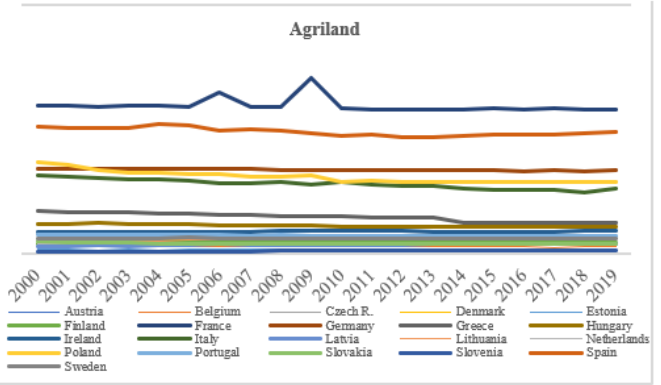
Figure 1. Indicators’ evolution (1995–2019). Source: Graphs made by the authors based on the analysed indicators.